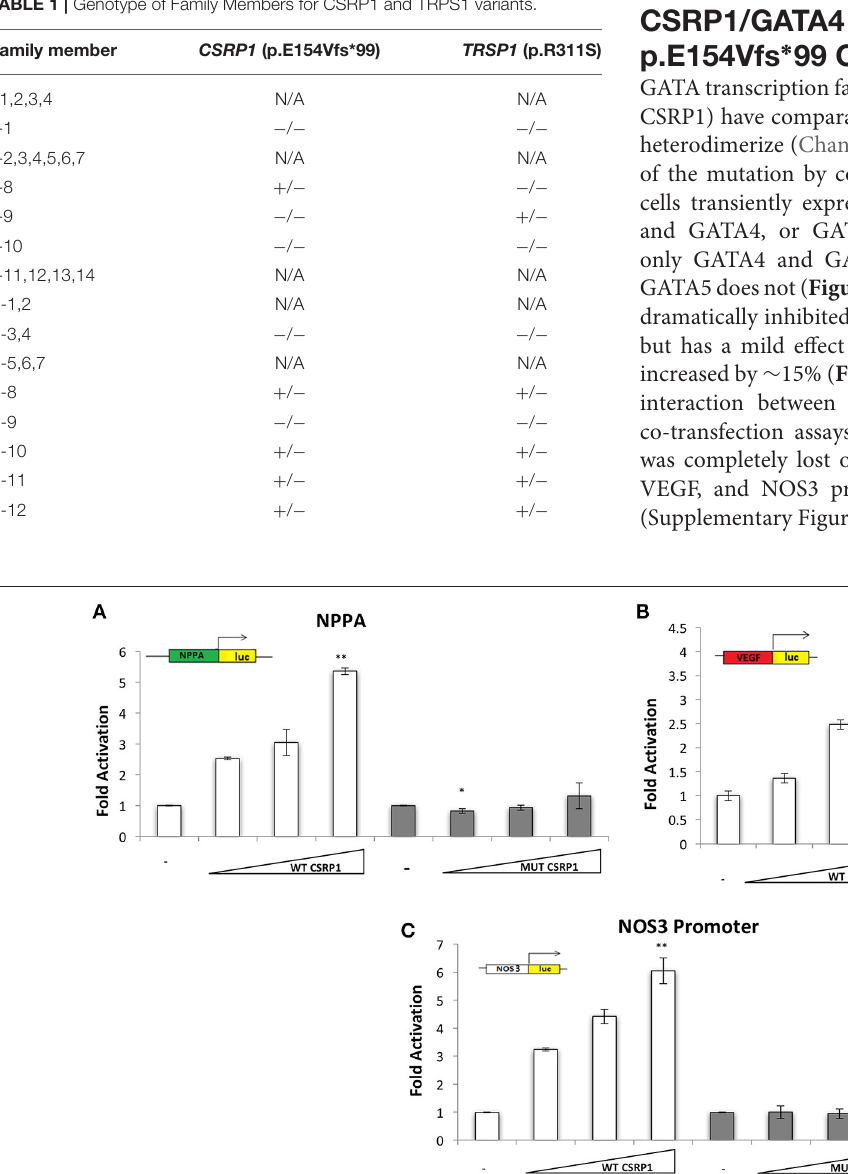
Frontiers in Genetics |